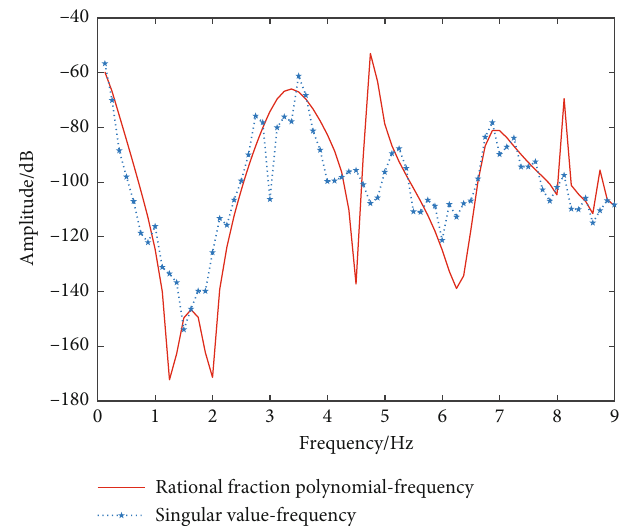
Figure 24: System identi fi cation result including the 3.3Hz and 6.7Hz.